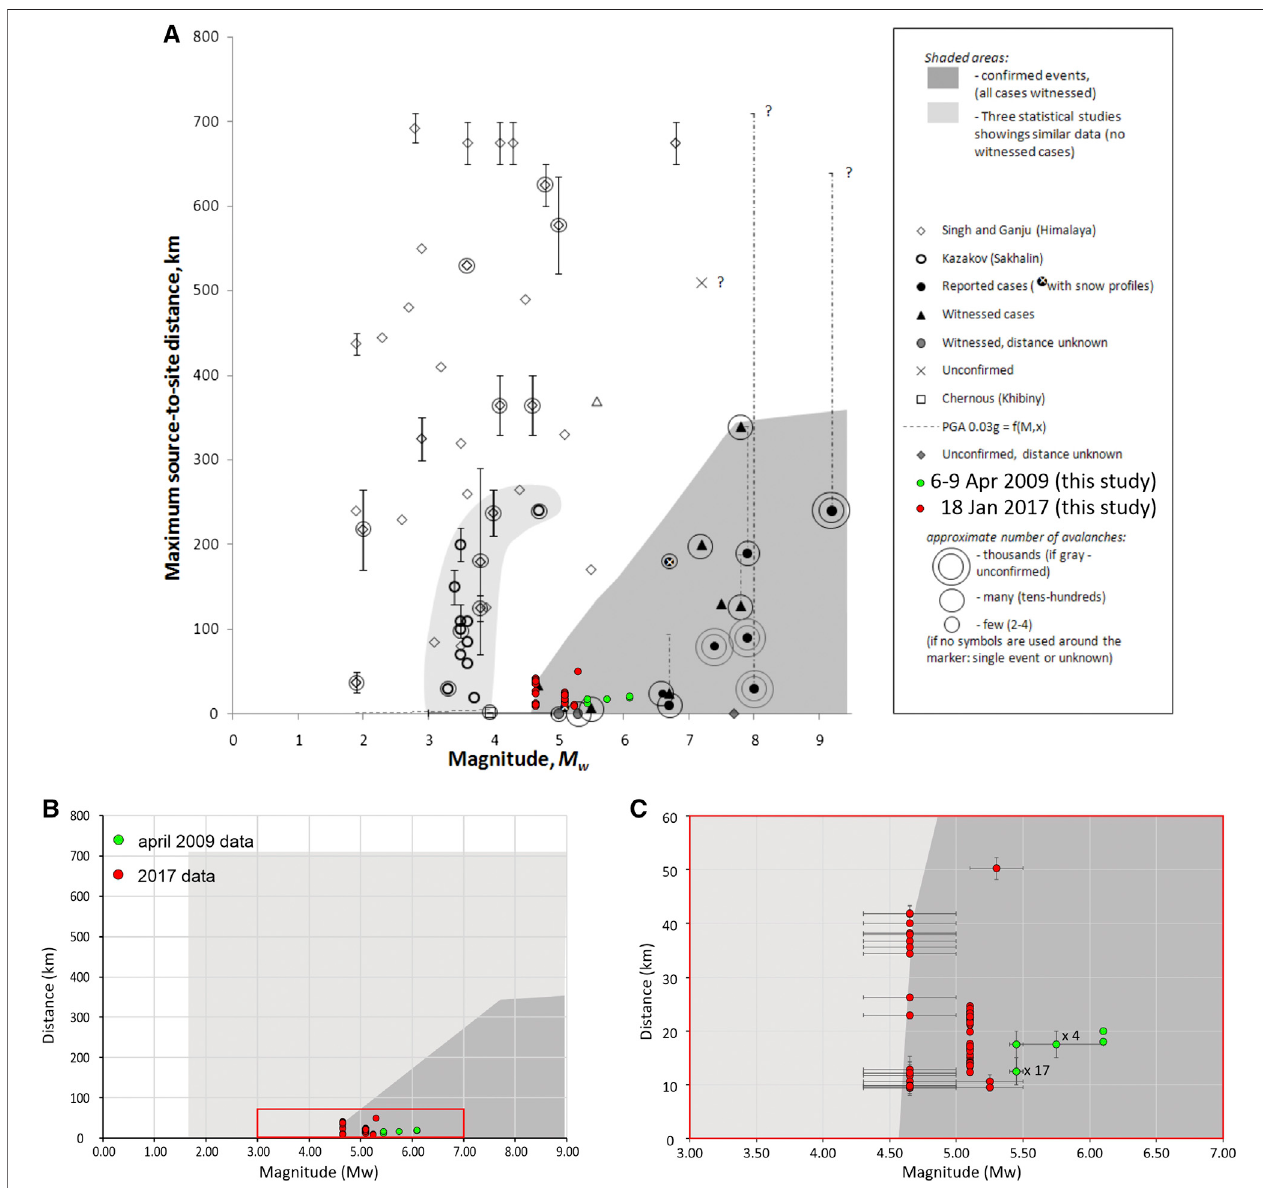
FIGURE 15 | (A) Magnitude vs. maximum source to site distance; statistical distribution of the seismically induced snow-avalanches modi fi ed from Podolskiy (2010). (B) Magnitudevs.avalanchesdistancetothesourceoftheavalanchesonApril6 – 9,2009(greendots)andonJanuary18,2017(reddots).Thegrayshadowsare the diagrams derived from Podolskiy (2010) (dark gray, the certain documented events; light gray, events derived from statistical distribution, see A ). The red box indicates the detail of the diagram in C . (C) Detail of the diagram magnitude vs. avalanches ’ distance to the source (red box from B ).